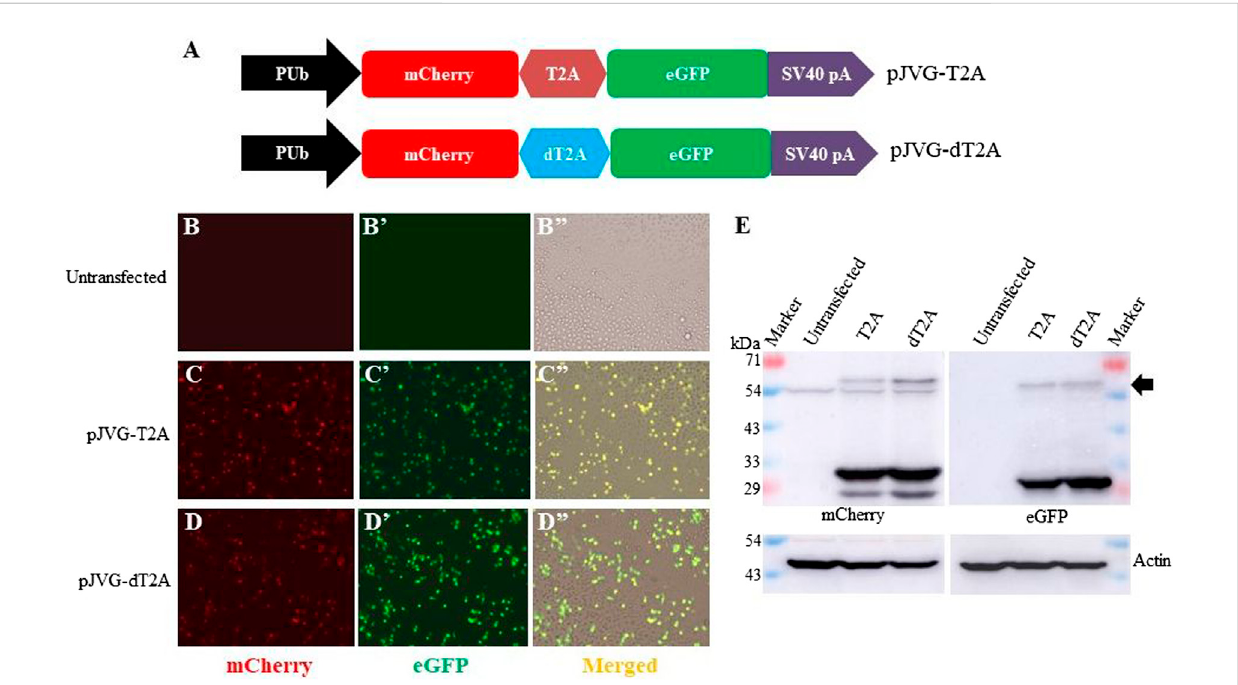
FIGURE 2 Ef fi ciency of T2A peptides in Aedes cells. (A) Schematic diagram showing the design of dual fl uorescent reporter cassettes to evaluate T2A (plasmid pJVG-T2A) and dT2A (plasmid pJVG-dT2A) activity. (B-D) Fluorescence micrograph of the cells transfected with plasmids as shown on the left of the panels. The untransfected cells (B-B ” ) were used to determine the baseline for imaging mCherry and eGFP channels, respectively. (E) Western blotting analysis of the extracts prepared from the transfected cells showing presence of processed mCherry and eGFP proteins. The blot was probed with anti-mCherry antibody (left panel) and anti-GFP antibody (right panel). Both blots were subsequently developed using anti-actin antibody. The arrow marks the position of the unprocessed mCherry-eGFP fusion